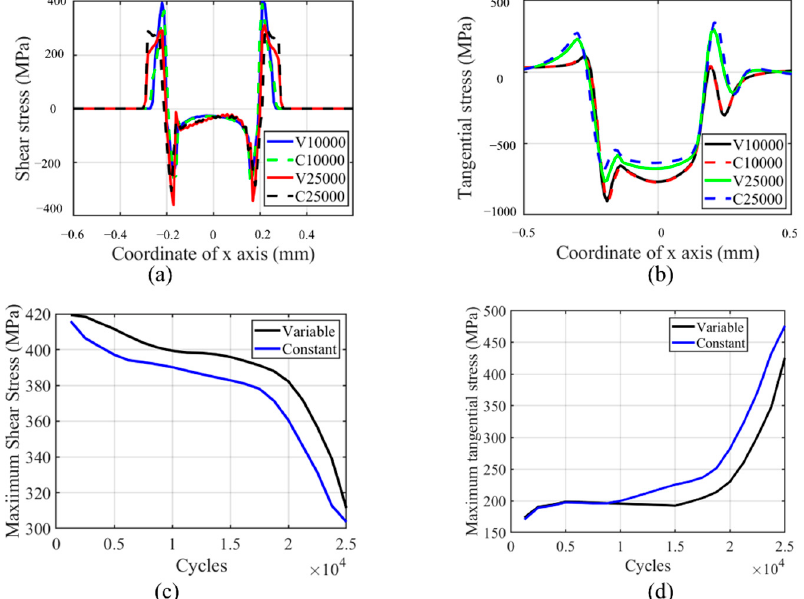
Figure 23. Profile and history of shear and tangential stress for the flat specimen in the partial slip regime for both CWCM and VWCM: ( a , b ) are shear and tangential stress profiles in 10,000th and 250,000th cycle when δ = 10 mm, and ( c , d ) are the history of maximum shear and tangential stress, respectively.